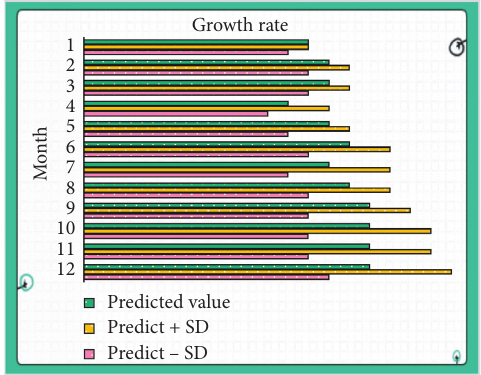
Figure 9: Forecast data of industrial added value growth rate